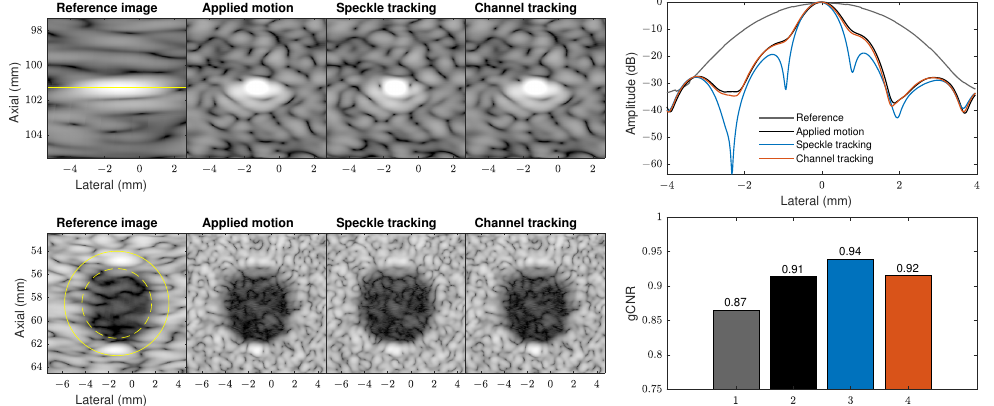
Figure 9. ( Top ) Point target images corresponding to the central point target at depth 100 mm from Figure 8. Yellow line indicates the depth for the lateral PSF. ( Bottom ) Lesion target images corresponding to the central large lesion target at depth 60 mm from Figure 8. Yellow circles indicate ROIs inside the dashed circle and outside the solid circle for gCNR calculation. All images show a 50 dB dynamic range. Both metrics show comparable performance for the two motion tracking techniques and similar performance to the applied motion case with slight improvements using speckle